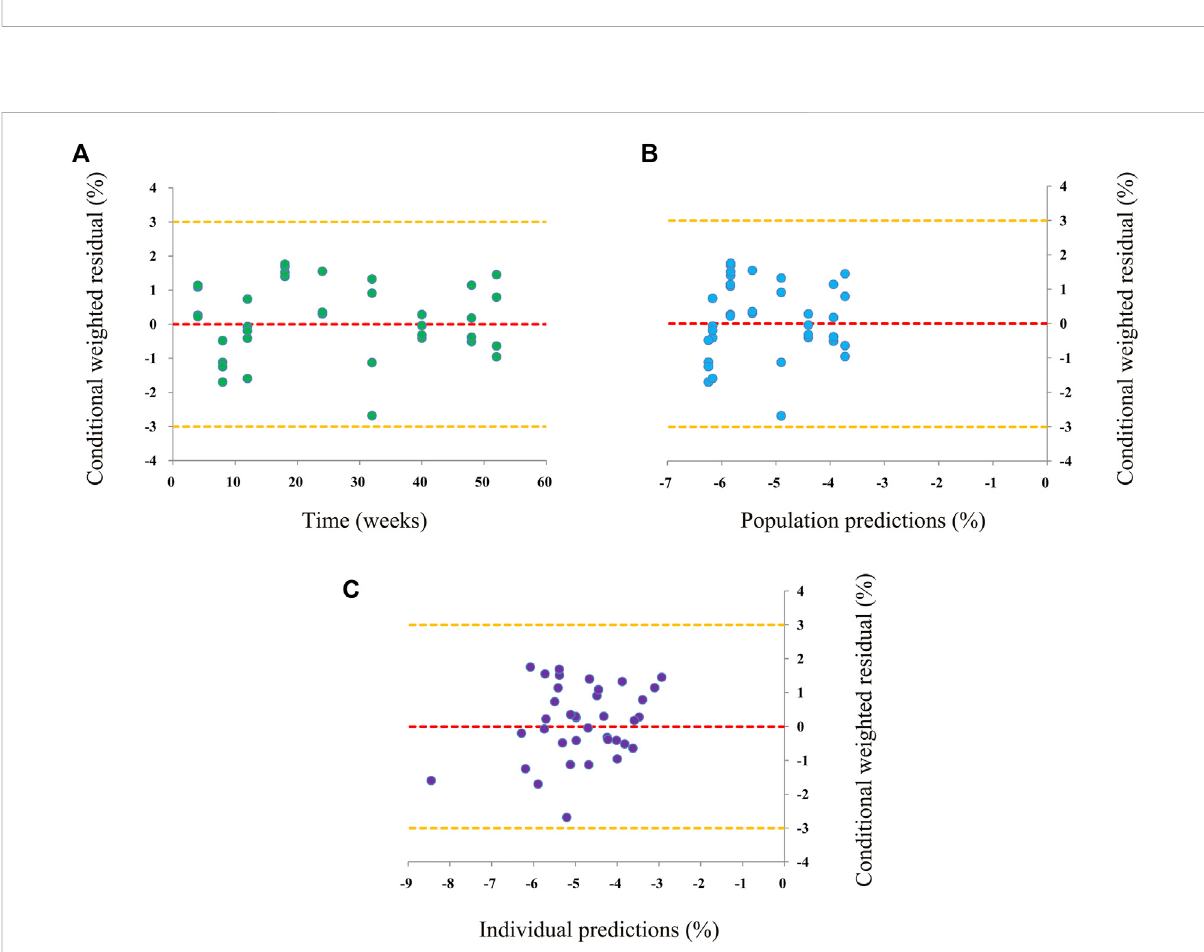
FIGURE 3 Conditionalweightedresidualofthe fi nalmodel. (A) Conditionalweightedresidual(CWRES)vs . time, (B) CWRESvs . populationpredictions,and (C) CWRES vs . individual